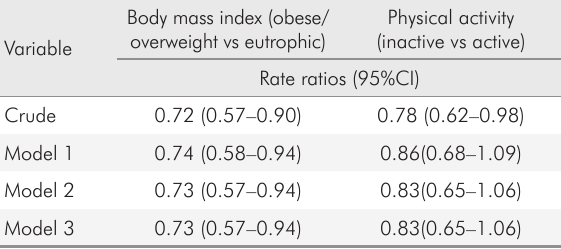
Table 3. Crude (c) and adjusted (a) rate ratios (RR) for dental caries severity (mean DMFT) and interest variables in Brazilian schoolchildren. Poisson regression analysis. (n = 1,210).